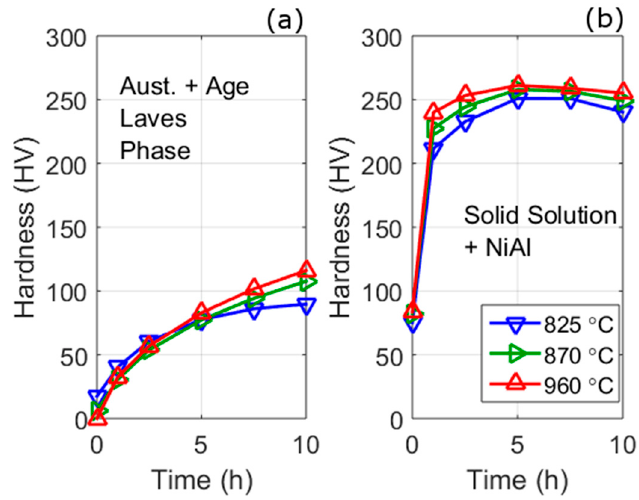
Figure 11. Strength predictions using SANS analysis separated based on contributions from Laves phase ( a ) and other mechanism ( b ).